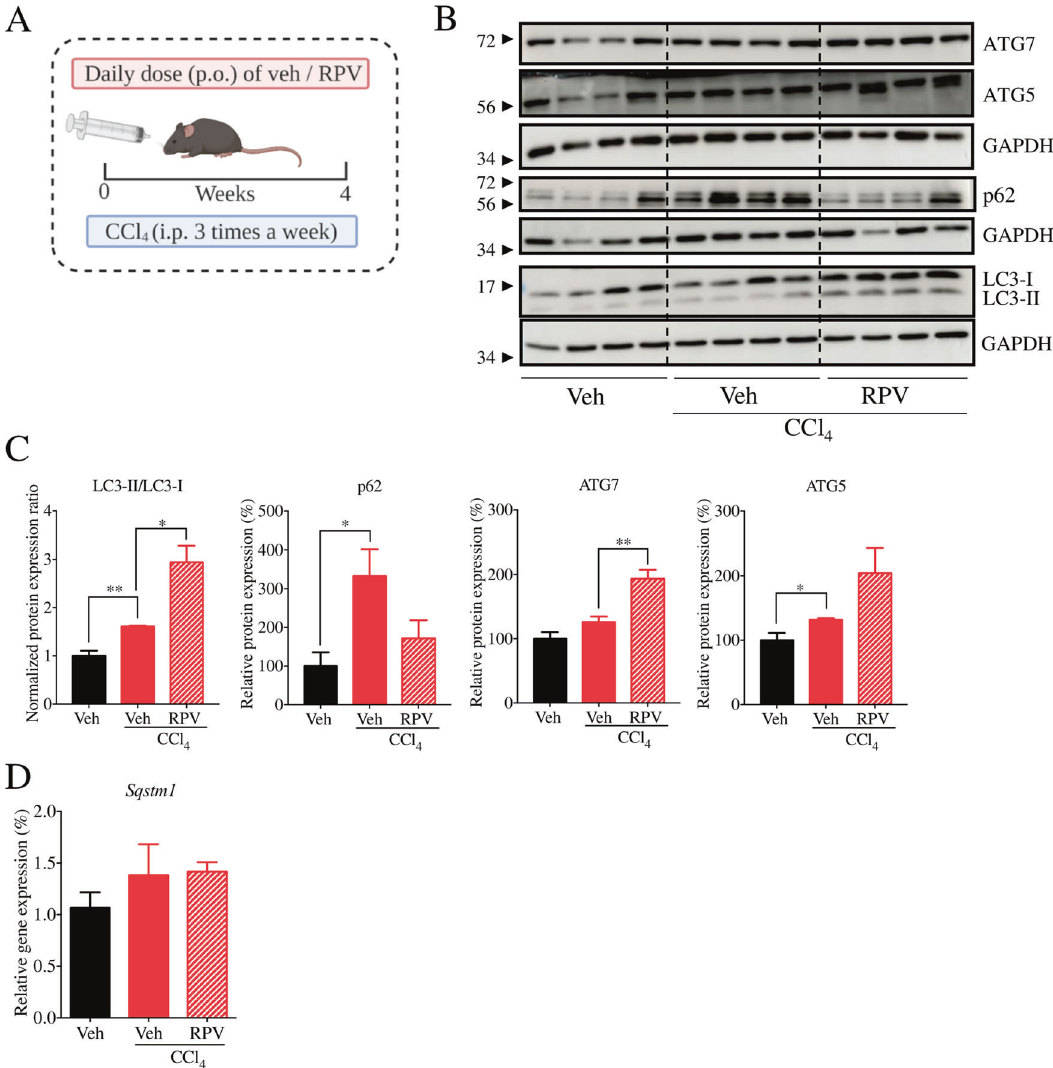
Fig. 2 Effect of RPV on hepatic autophagy in a murine model of chronic liver injury induced by a hepatotoxic chemical. A Female C57BL/ 6 J mice were treated for 4 weeks with Veh (DMSO), carbon tetrachloride (CCl 4 ) + Veh or CCl 4 + RPV. CCl 4 (0.5 mg/kg) dissolved in 50 μ L of corn oil was administered intraperitoneally in alternate days while either RPV (5 mg/kg/day) or its vehicle (Veh, DMSO) were orally administered (p. o.). B Representative WB images of p62, LC3, ATG5 and ATG7 from total liver protein extracts from 4 mice per group. C Ratio of LC3-II/LC3-I levels obtained through densitometric analysis of LC3 signal from WB. Values were normalized to the ratio in the Vehicle group which was considered 1. Densitometric analysis of p62, ATG5 and ATG7 signal from WB images. Protein expression was normalized with that of GAPDH. D Relative gene expression of Sqstm1 (p62) obtained through RT-qPCR from total liver RNA using Actb (actin) as a housekeeping gene. Protein and mRNA levels in the Vehicle group were considered 100%. Data represented as mean ± SEM ( n = 4) were statistically analysed by